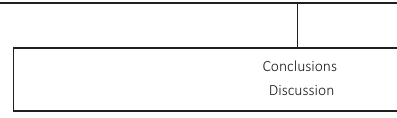
Figure 2. The technical route on the